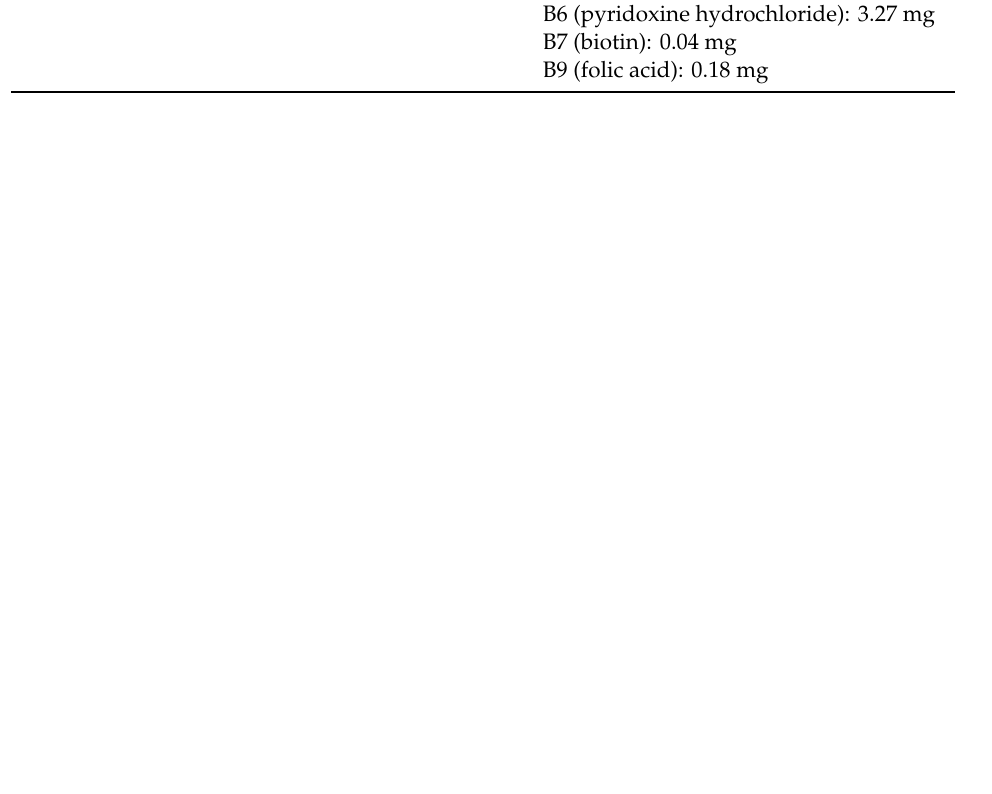
Components of vitamin B (in 100 g of rice